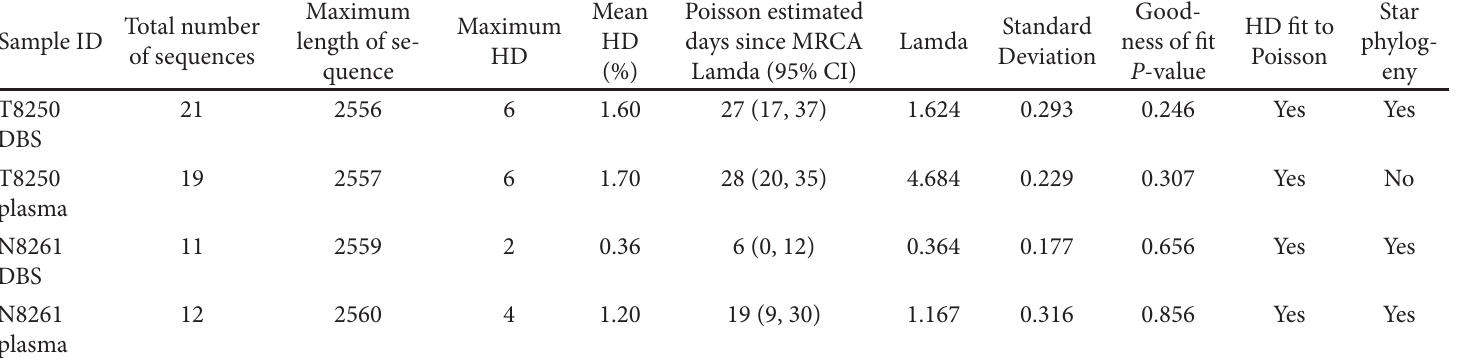
Table 3. Statistics and mathematical model estimates of the most recent common ancestor (MRCA) of HIV env sequences derived from DBS and plasma in two acutely infected individuals Total number Sample ID of